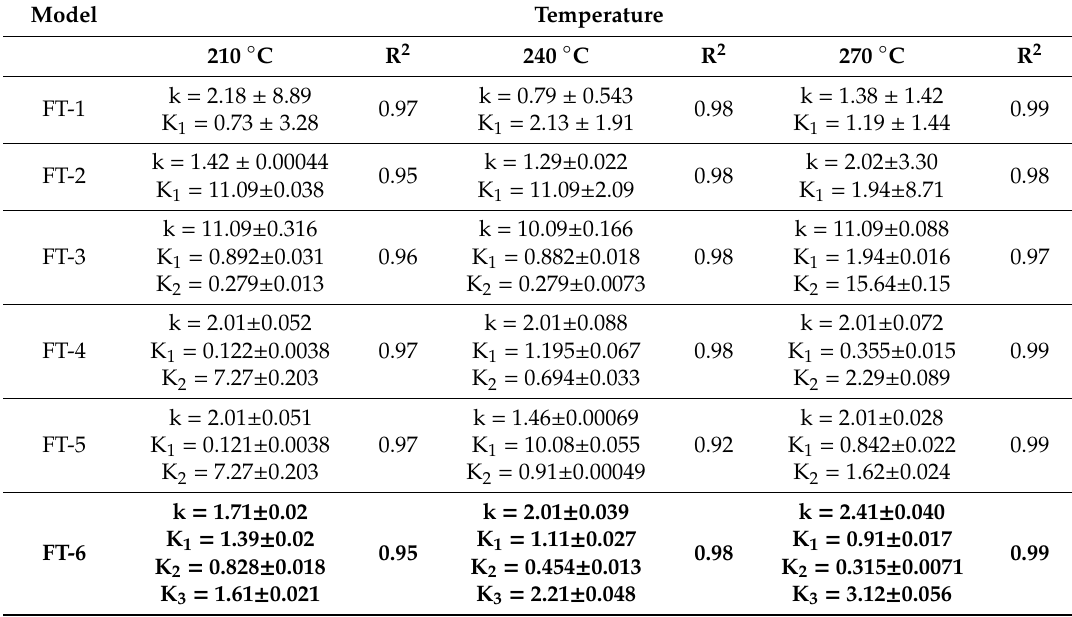
Table 7. Kinetic parameters obtained from all the proposed mechanisms for CoRu-KIT-6.